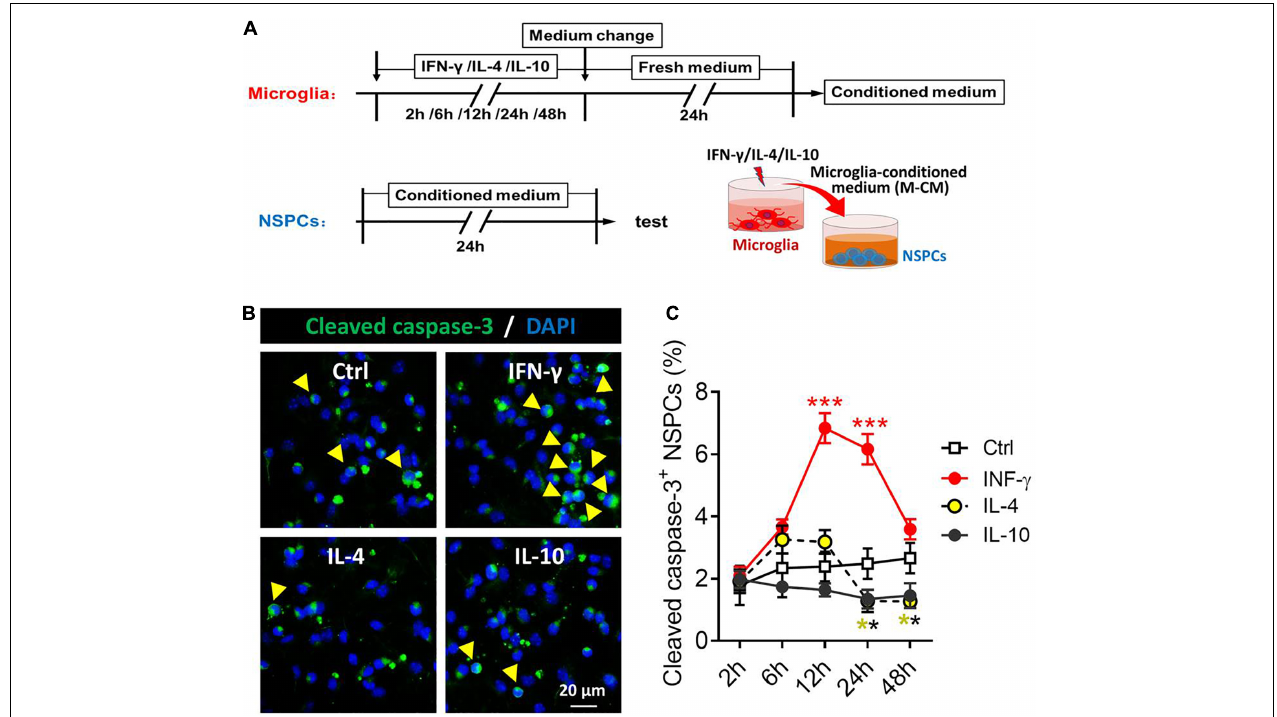
FIGURE 7 | Neurotoxicity of microglial phenotypes induced by IFN- γ , IL-4, or IL-10. (A) Experimental scheme to monitor neurotoxicity during activation. Microglia underwent stimulation with IFN- γ , IL-4, or IL-10 for 2–48 h, then the medium was changed and the cells were cultured with fresh medium for 24 h. The microglia-conditioned medium (M-CM) was collected and configured as a proliferation medium for neural stem/precursor cells (NSPCs). The NSPCs were cultured with M-CM for 24 h and the apoptotic NSPCs were detected. (B) Representative micrographs showing immunocytochemical labeling for cleaved caspase-3 in NSPCs treated for 24 h with conditioned medium from IFN- γ -, IL- 4-, or IL-10-stimulated microglia. (C) Quantification of the percentages of cleaved caspase-3 + -DAPI + cells following treatment with conditioned medium from IFN- γ -, IL-4- or IL-10-stimulated microglia for 2–72 h. Five, 40 × micrographs were taken from each well, and all cells in the field were measured. Data are presented as mean ± SEM ( n = 4–6 well per group), ** P < 0.01, *** P < 0.005 (one-way ANOVA with Tukey’s multiple-comparisons